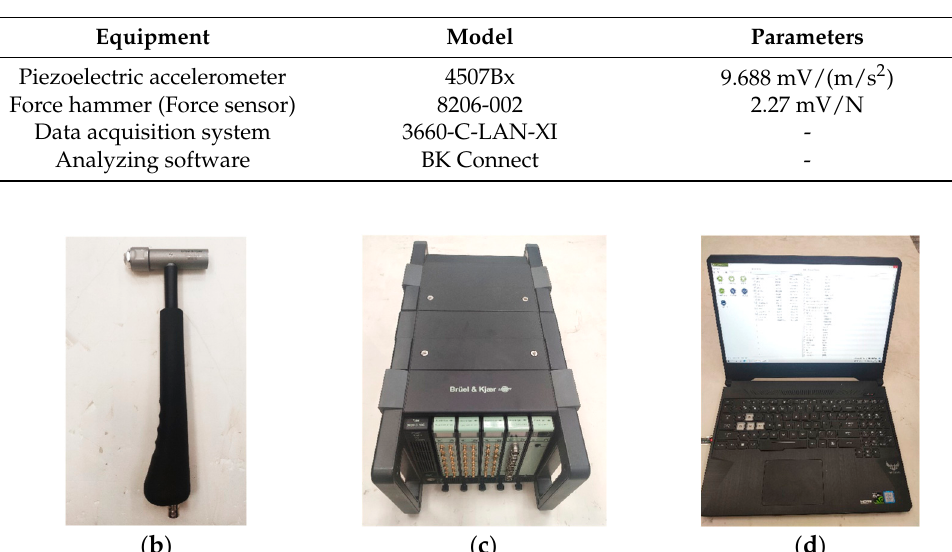
Figure 6. Hammer experiment equipment. ( a ) Piezoelectric accelerometer, ( b ) force hammer, ( c ) data acquisition system, ( d ) data processing system. Table 2. The parameters of the experiment equipment.